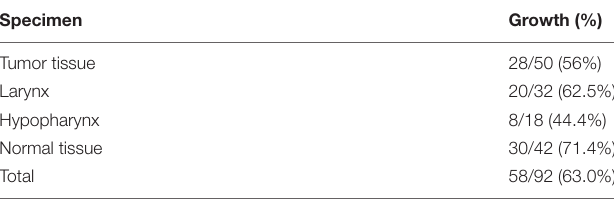
TABLE 2 | Success rate of CRC culture. Specimen